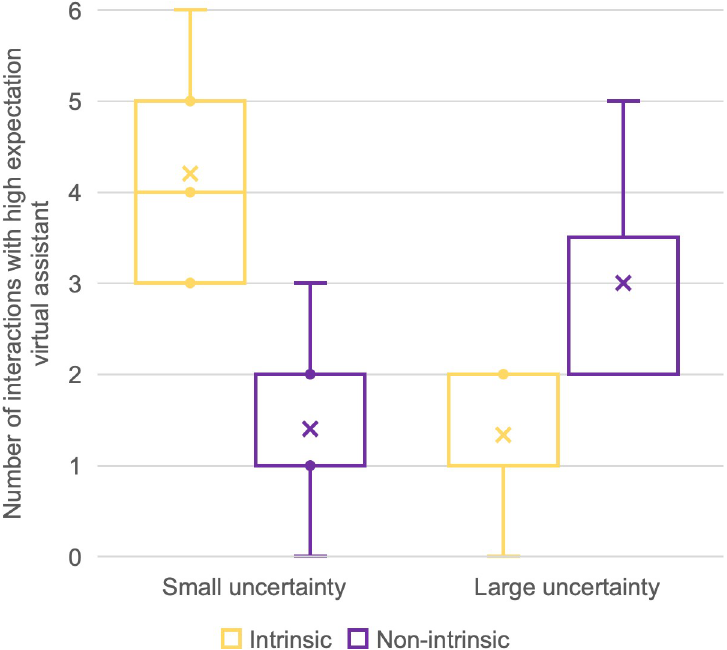
Fig 14. Number of interactions with the high-expectation virtual assistant. Sorted by uncertainty group and motivation type.